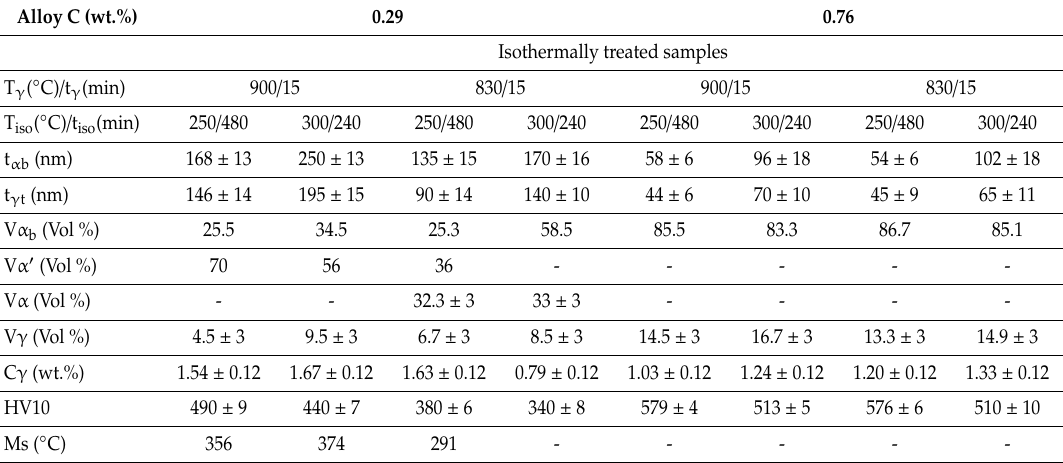
Table 5. Microstructural characterization data from the samples isothermally transformed. Where, V γ and C γ stand for the volume fraction and carbon content of austenite measured by XRD. V α is the fraction of proeutectoid ferrite measured by point counting. From dilatometric curves the martensite start temperature, Ms and fraction of martensite V α ’ are derived. Fraction of bainitic ferrite V α b = 100 + V + V − (V γ α α (cid:48) ). Finally, t α b and t γ t stands for the bainitic ferrite and retained austenite thin film thicknesses,